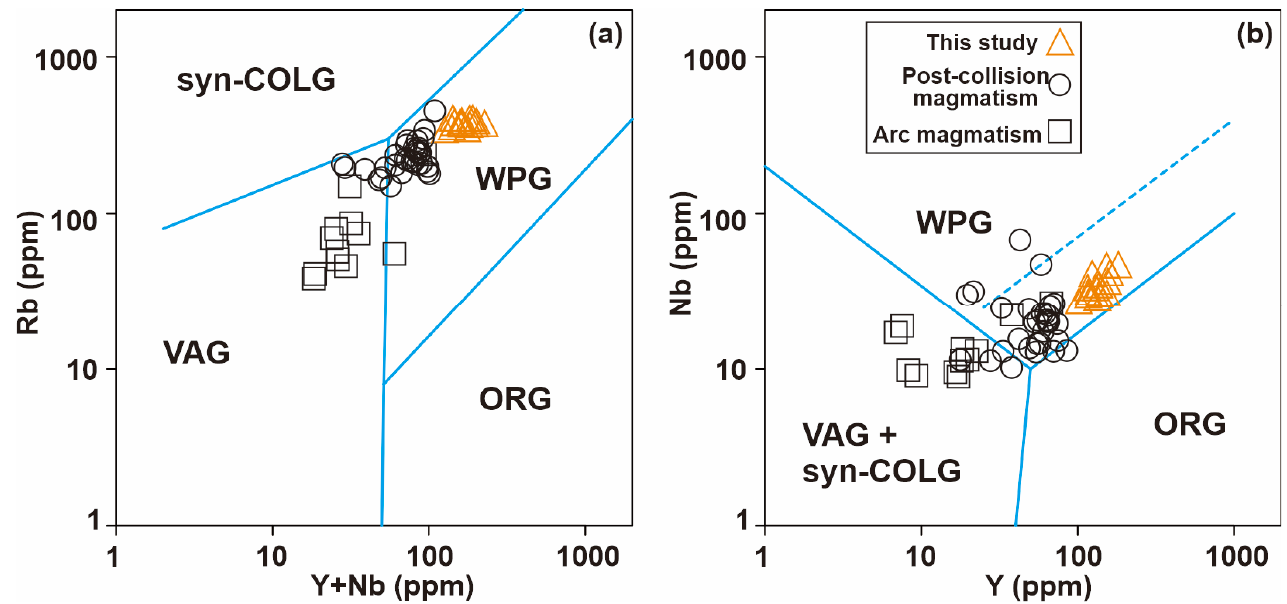
Figure 9. Geotectonic discrimination diagrams of granitoids from the middle of the Huaniushan arc. ( a ) Rb vs. Y + Nb diagram [65]; ( b ) Nb vs. Y diagram [65]. Geochemical data of post-collision and arc magmatism from [15,18,22–28]. Syn-COLG = syn collisional granite; VAG = volcanic arc